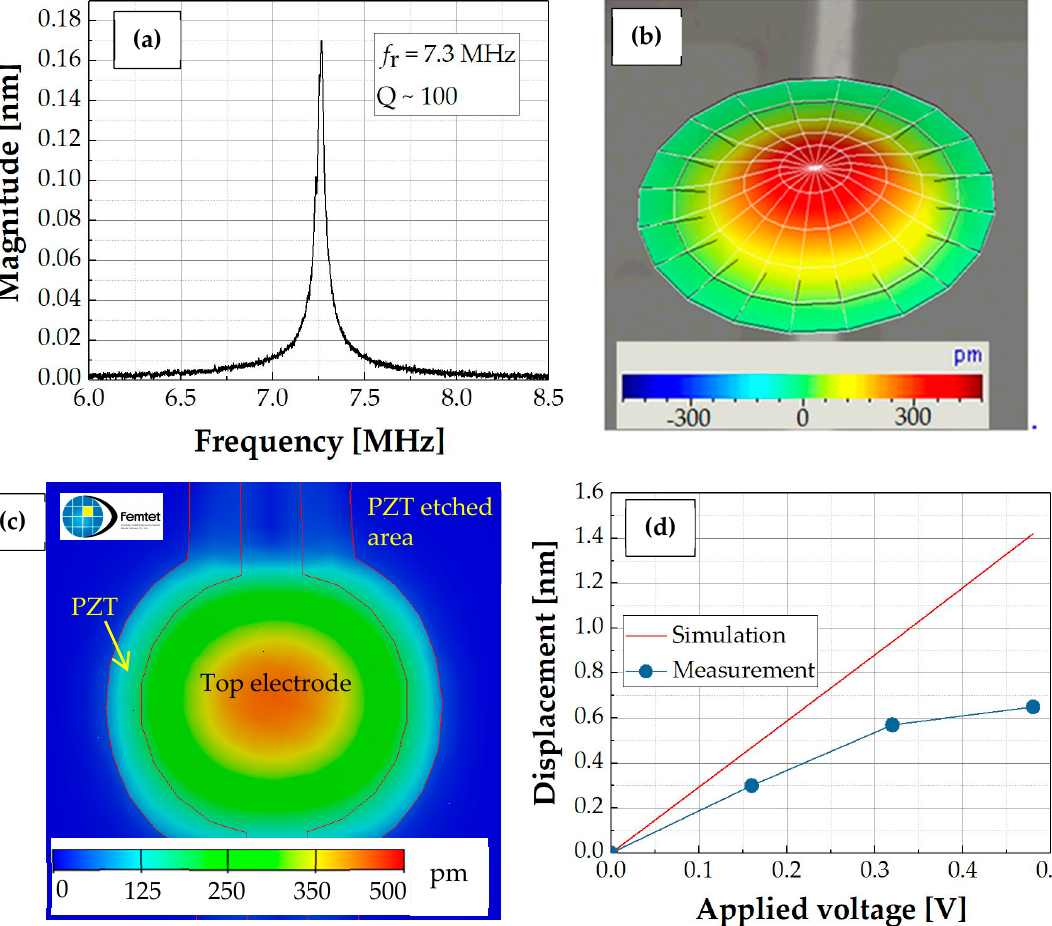
Figure 9. ( a , b ) Laser Doppler vibrometer (LDV) measurement results for 60 µm diameter of PZT PMUT by applying 0.16 V of driving voltage; ( c ) Simulation result on pMUT with the same geometry and operating condition as the real device; ( d ) Comparison between the simulation and measurement results.